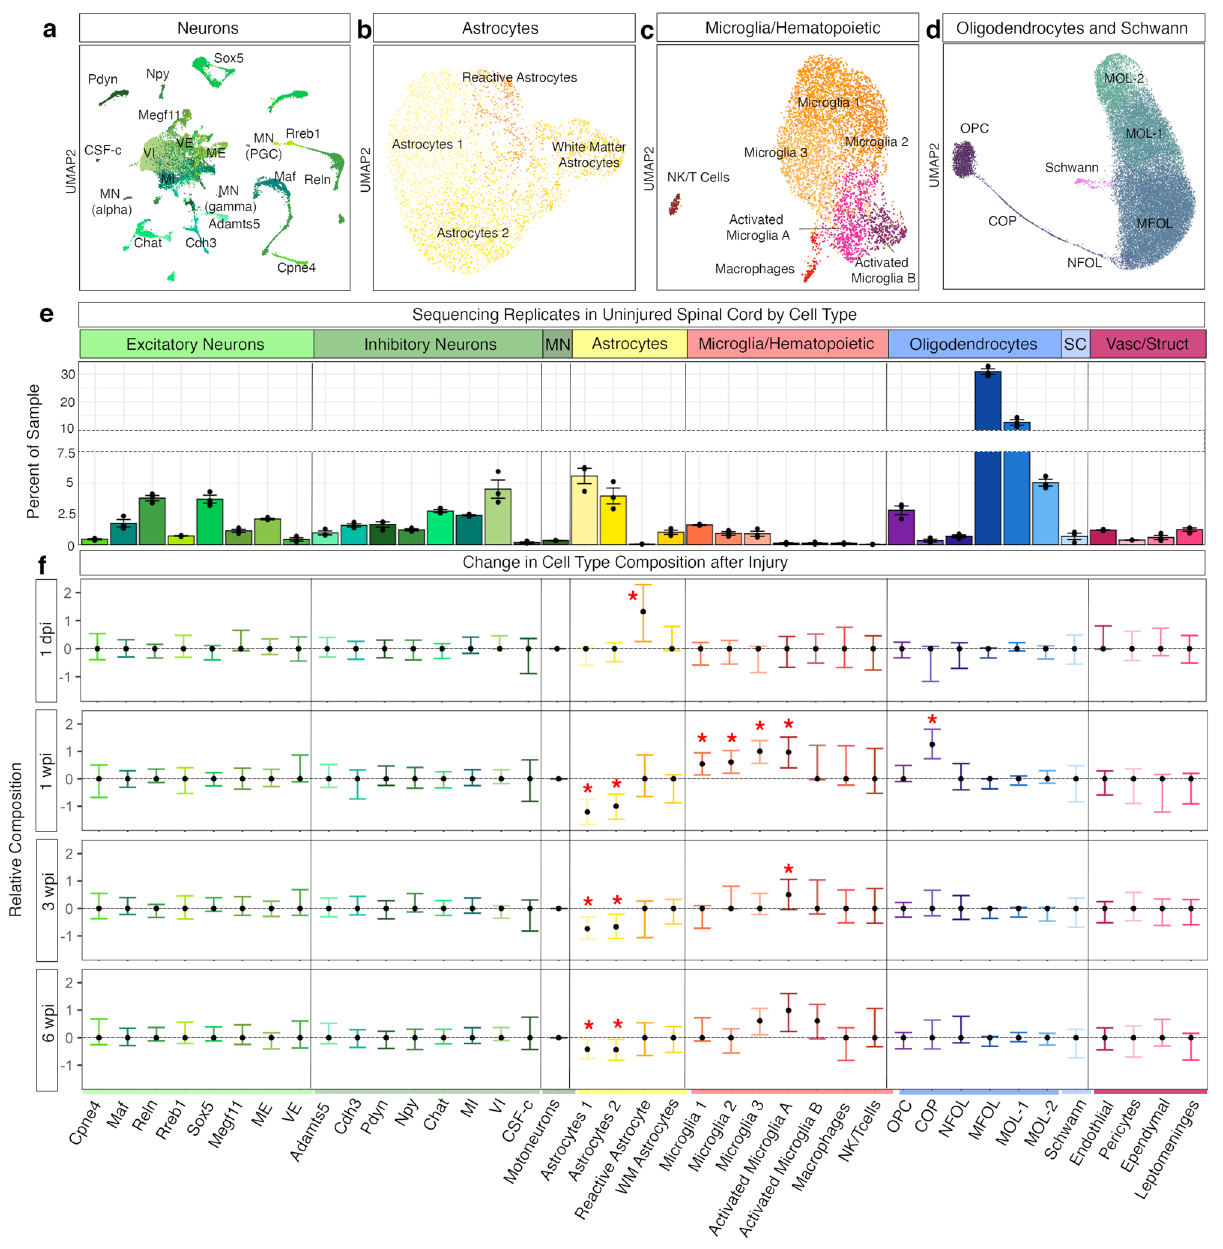
Fig. 2 | Cell type composition in the uninjured spinal cord and after injury. a – d UMAPs depicting subclustering of major cell types: a neurons, b astrocytes, c microglia/hematopoietic cells, d oligodendrocyte lineage and Schwann cells. e A bar plot showing the 39 cell types in the atlas and their relative percent in each sample in the uninjured spinal cord. Individual replicates ( N =3) are shown as well as mean±SEM. f The relative composition of the 39 cell types comparing injured